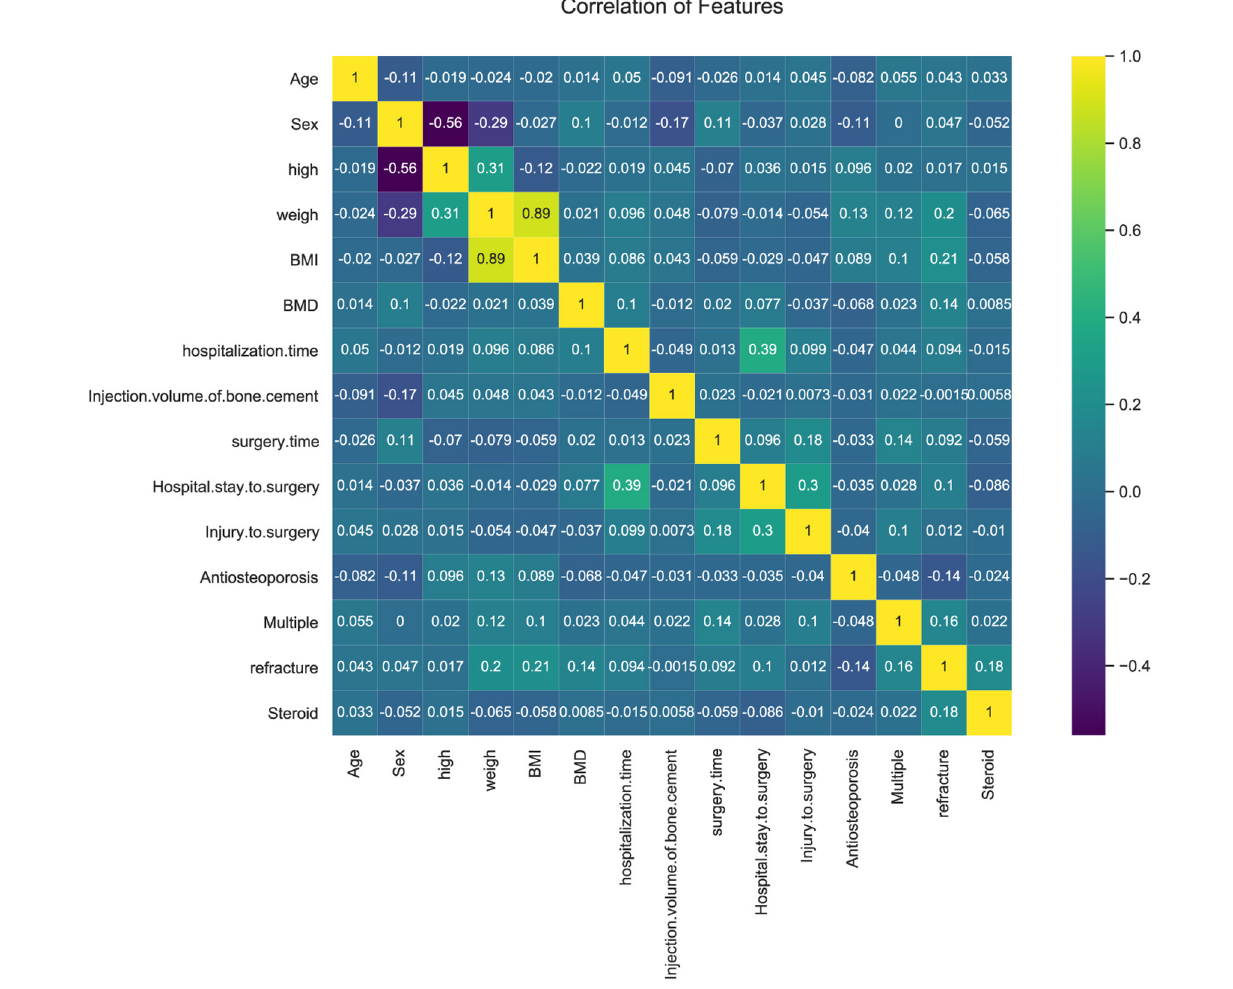
FIGURE 1 | Heat map of the correlation of patient’s clinical